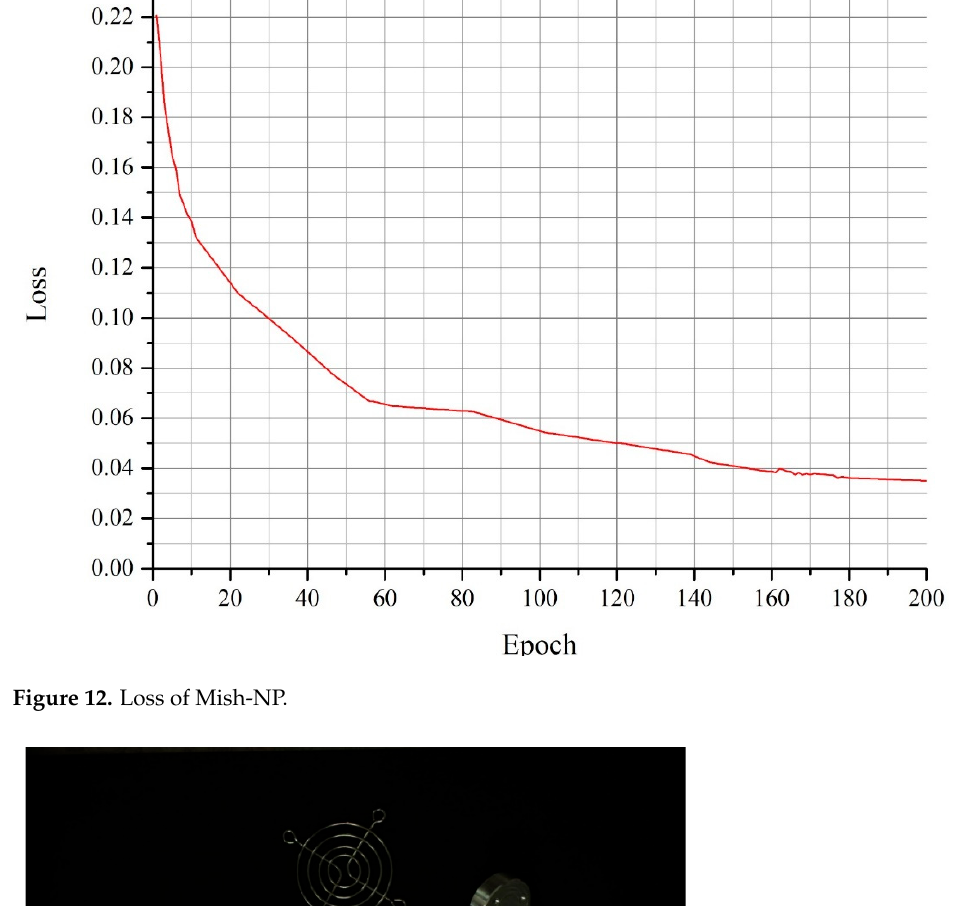
Figure 12. Loss of Mish-NP.